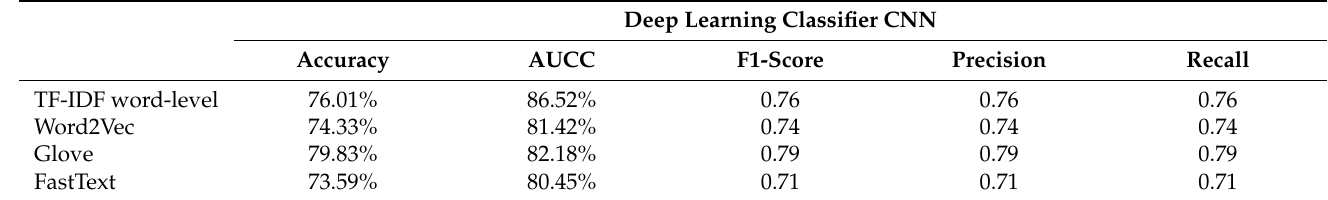
Table 3. CNN classifier performance with feature extraction.